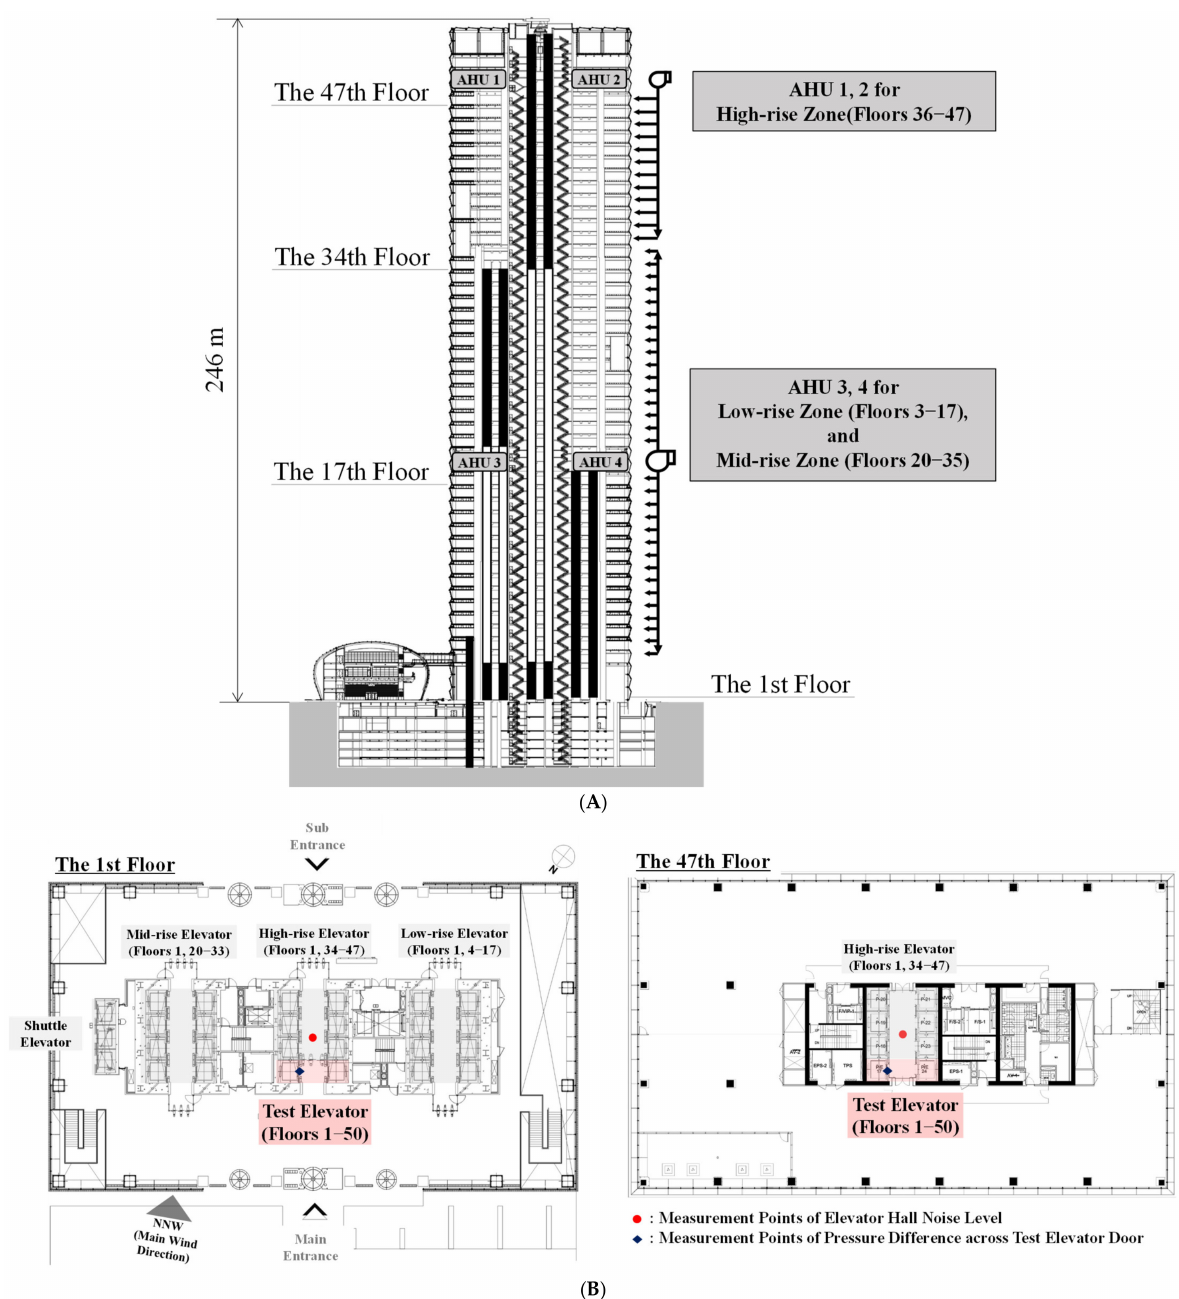
Figure 5. ( A ) Vertical zoning of elevators and HVAC systems in the building A; ( B ) floor plans and measurement locations on the 1st floor and 47th floor in the building